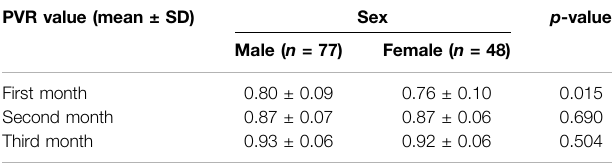
TABLE 2 | Subgroup analysis for the early PVR based on sex.